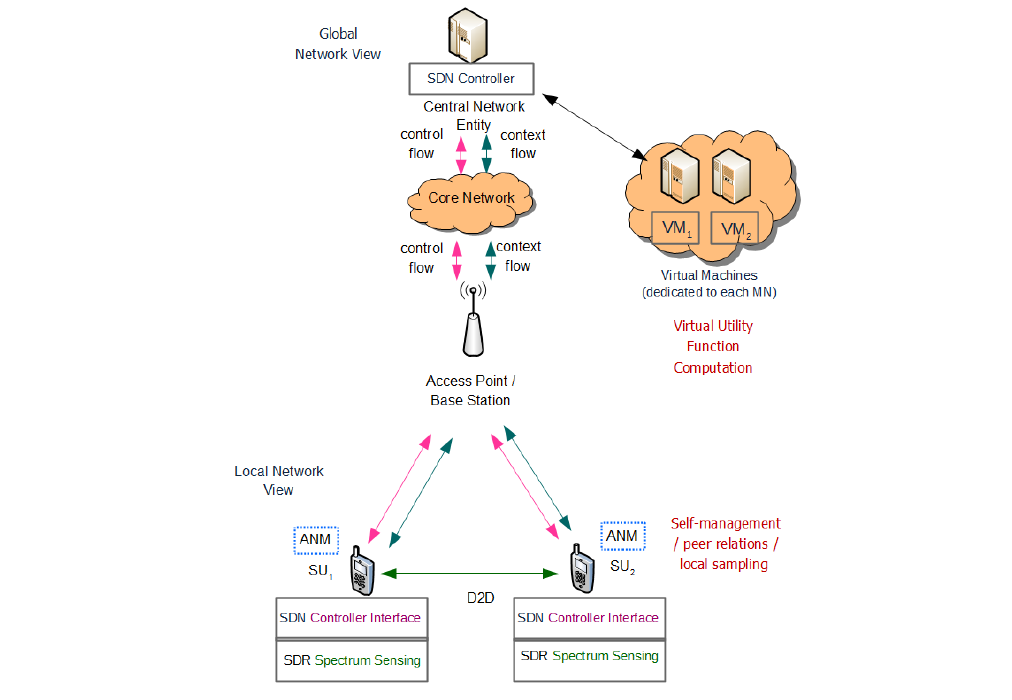
Figure 3. Hybrid ANMO-SDR